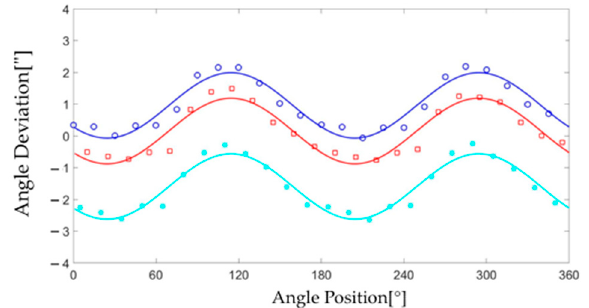
Figure 9. Calibration results for curve fitting at three shift-angles. S = 0 ° , blue solid line for curve fitting and circle label for the measured values; S = 5 ° , light blue solid line for curve fitting and star label for the measured values; and S = 10 ° , red solid line for curve fitting and rectangular label for the measured values.